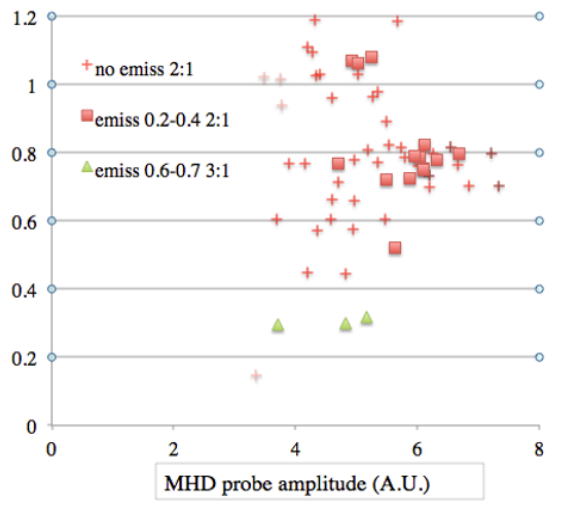
Fig. 3. Distribution in density and MHD amplitude of shots with emission of Type 2 (squares) and Type 7 (triangles) with respect to those without emission (crosses).